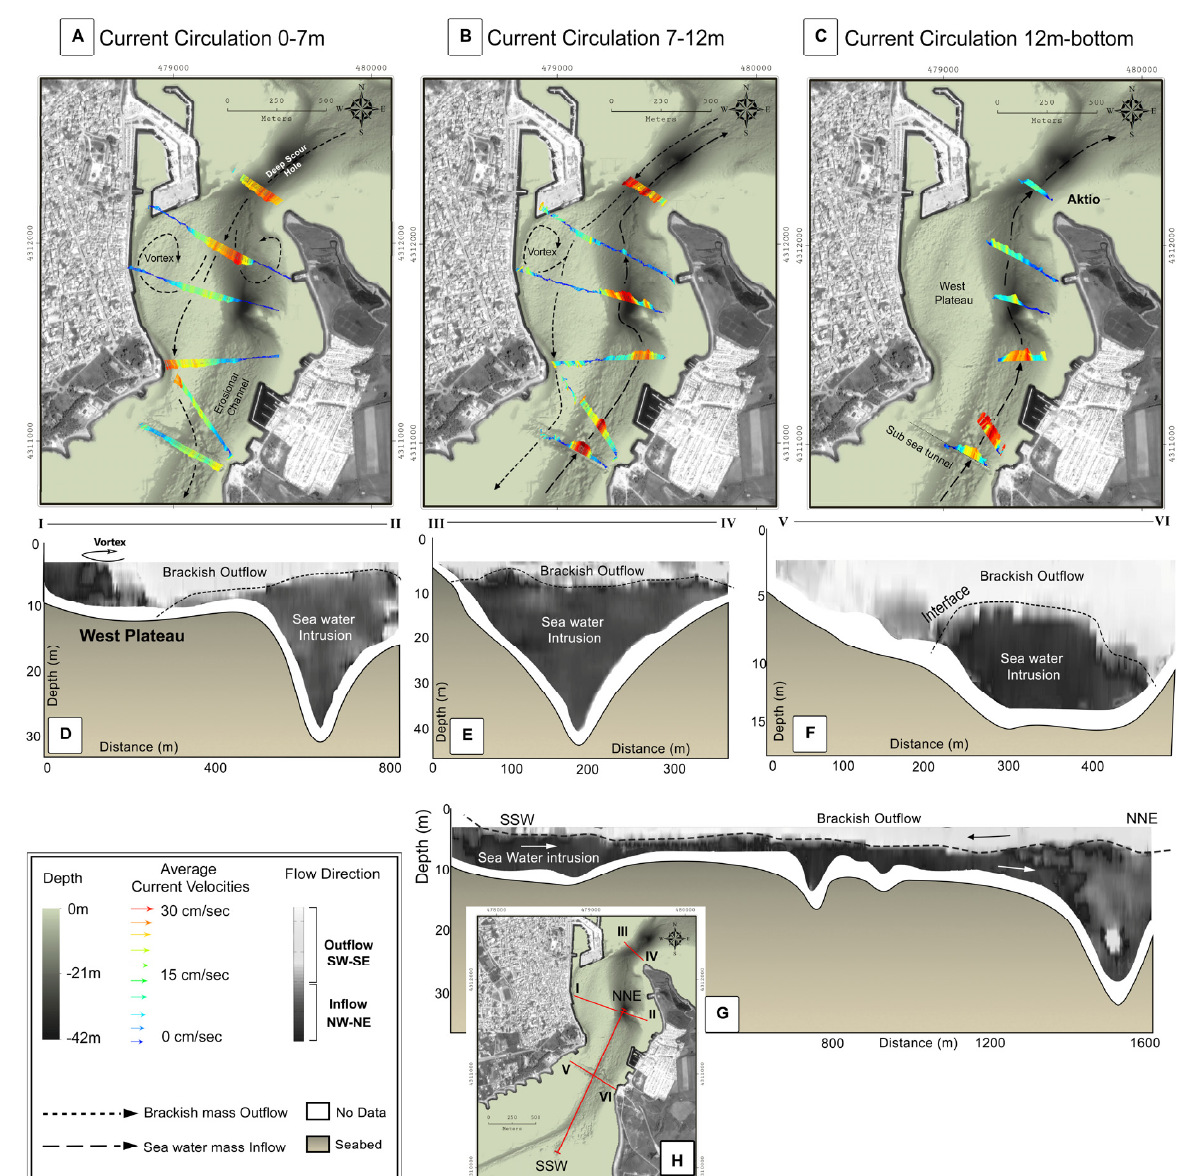
Figure 2. Two-layer circulation pattern distinguished in three different levels: ( A ) 0–7 m, ( B ) 7–12 m, and ( C ) 12-bottom; ( D ) cross-section showing the flow direction perpendicular to the straits as indicated in map 2 h; ( E ) flow direction cross- section perpendicular to the straits as indicated in map 2 h; ( F ) flow direction cross-section perpendicular to the straits as indicated in map 2 h; ( G ) ADCP profile parallel to the Preveza Strait showing the brackish mass outflowing to the SSW on the top part of the water column and the seawater flowing into the gulf; and ( H ) a map showing the location of d, e, f, and g (sections presented in this figure were made using the VMT software